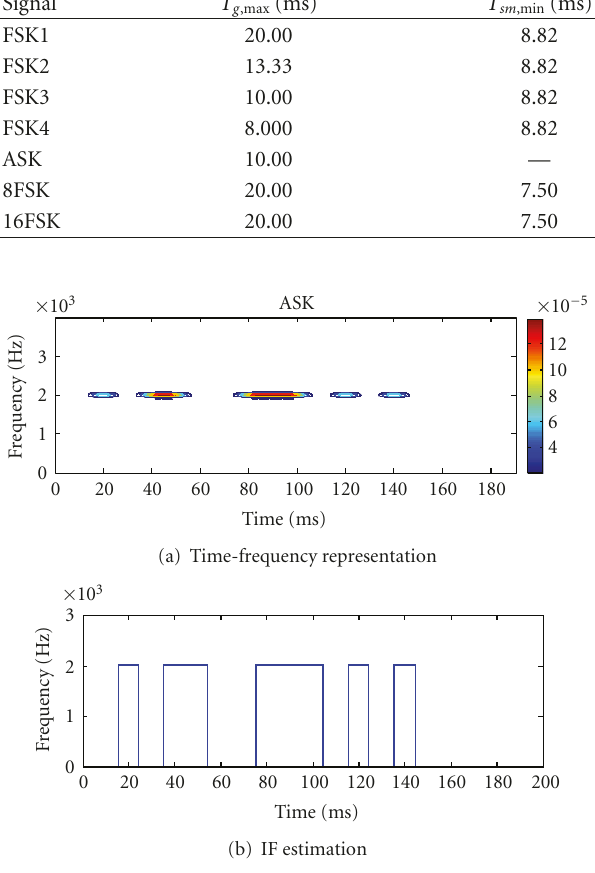
Figure 4: Time-frequency representation and the instantaneous frequency estimate from the TFR of ASK signal using T g = 10 milliseconds, T sm = 10